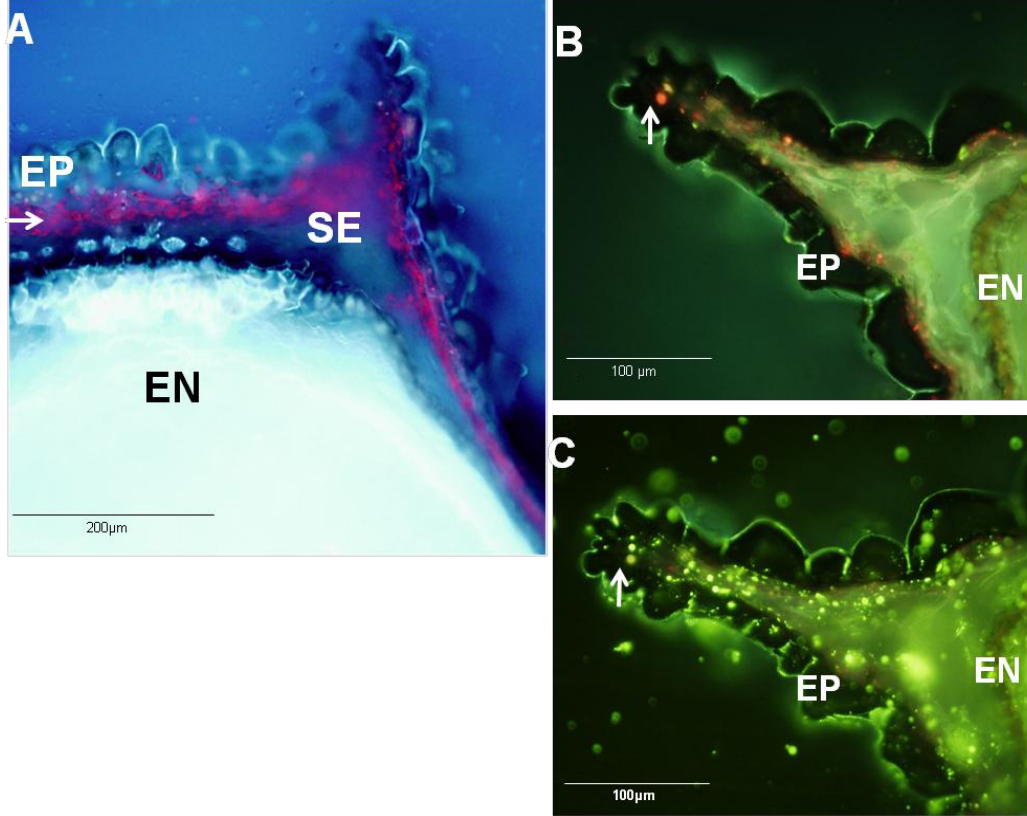
Figure 5. Fluorescence micrographs of longitudinal sections of mature N. sativa seed. ( A ) Autofluorescence under UV light excitation. Pink-fluorescent droplets are observed in the subepidermal layer (SE) of the seed coat. ( B ) Blue light excitation fluorescence. The lipophilic droplets display a red fluorescence indicated by white arrows. ( C ) The same section under blue light excitation after staining with fluorol yellow 088, the droplets display a yellow fluorescence typical to lipophilic material (white arrows).